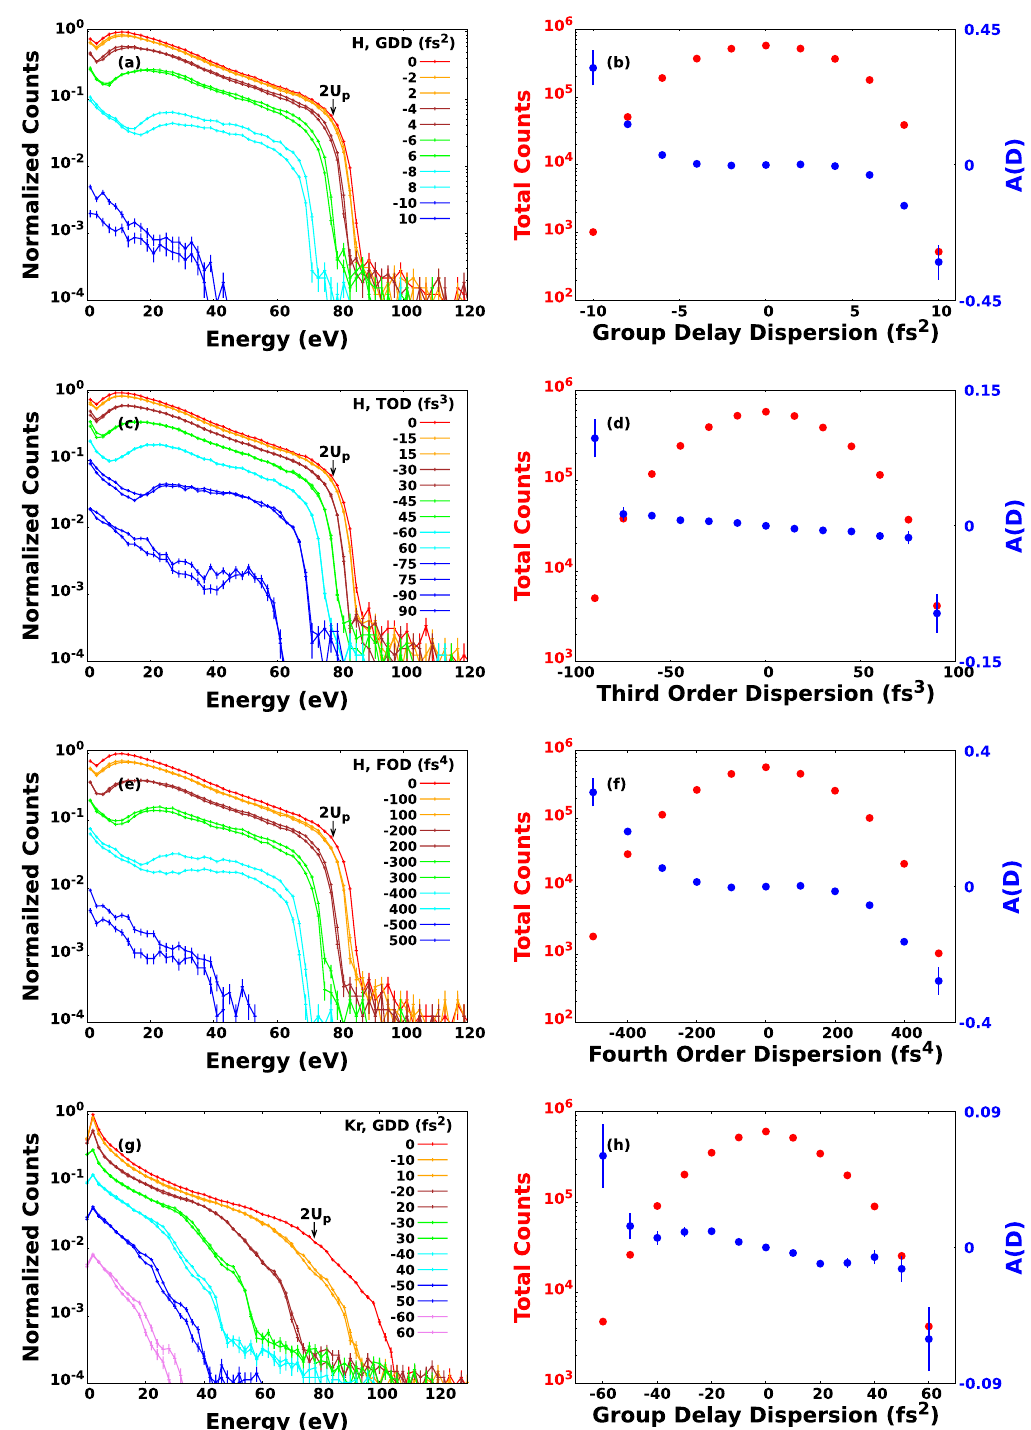
Figure 3. Photoelectron spectra for hydrogen calculated with different GDD ( a ), TOD ( c ) and FOD ( e ). The corresponding number of electron counts and asymmetry parameters defined by Eq. (17) can be seen on the right column with error bars. Panels ( g and h ) refer for krypton and only for GDD. On the left column we have 10 14 W / cm 2 marked 2 U p where U p means the ponderomotive potential at 6.5 ×